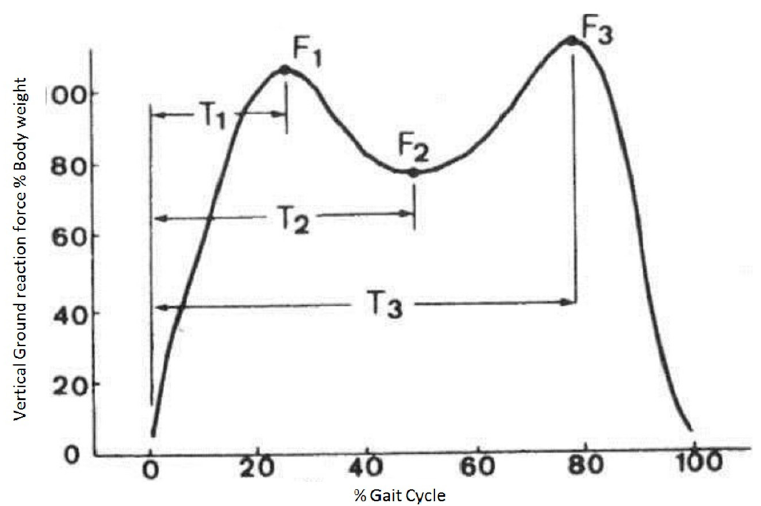
Figure 5. Selected time moments. At those 6 points (left and right together), the values of the vertical ground reaction force and the position of the trunk and pelvis in all three planes were recorded. These values were used for statistical comparison before and after intervention in the same group and between groups. The trunk was assessed as a compact structure starting from the 7th cervical vertebra and ending in the 5th lumbar vertebra (Figure 6).